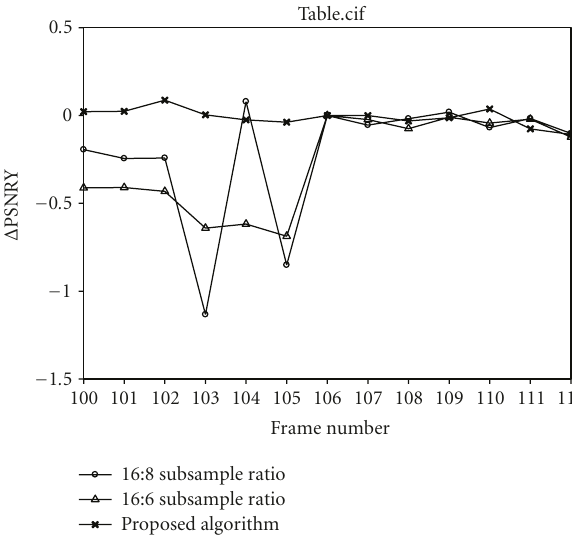
Figure 9: The dynamic variation of FSBM quality degradation with fixed subsample ratios and proposed algorithm.